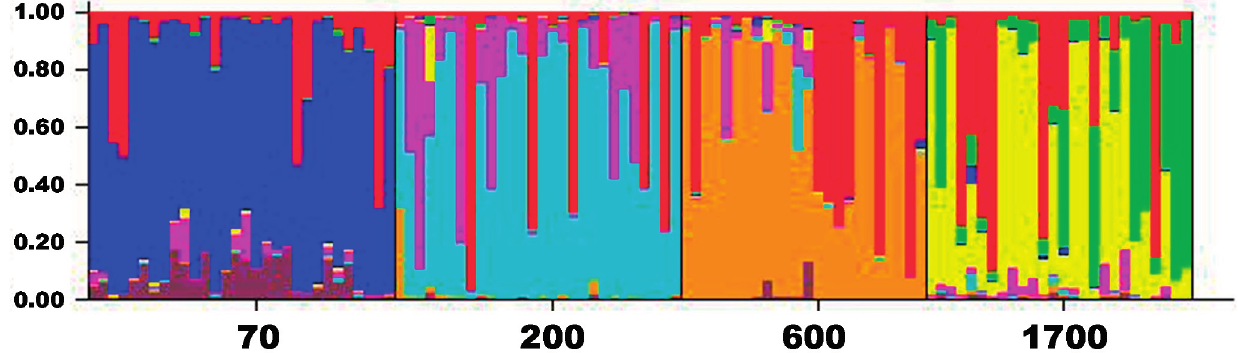
Figure 2. Population structure based on ISSR variation among sites at K = 8, implemented in STRUCTURE, v. 2.3, where each line represents the proportional assignment of an individual to the clusters, represented by the different colors.